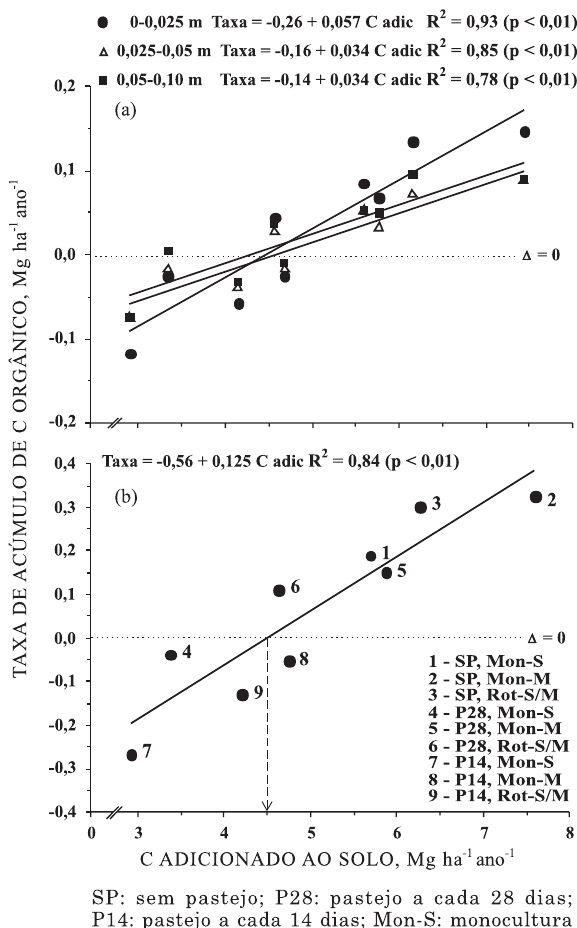
Figura 2. Relação entre a adição de C via resíduos vegetais e as taxas de acúmulo de C orgânico nas camadas de (a) 0–0,025, 0,025–0,05, 0,05– 0,10 m e (b) 0–0,10 m do